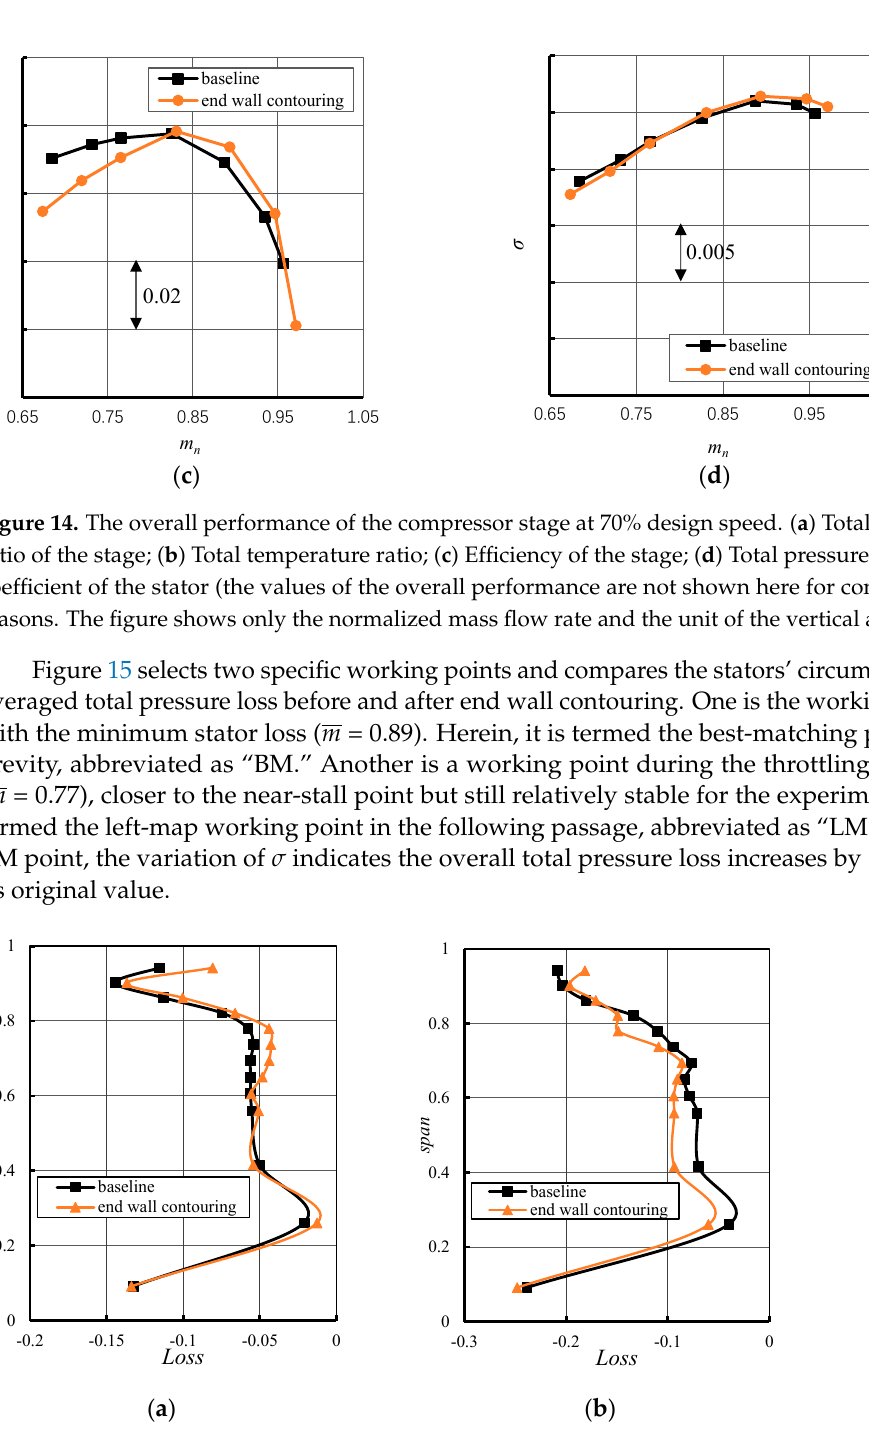
Figure 15. The circumferential averaged loss coefficient of the stator at 70% design speed. ( a ) ⎯ m = 0.89; ( b ) ⎯ m = 0.77.